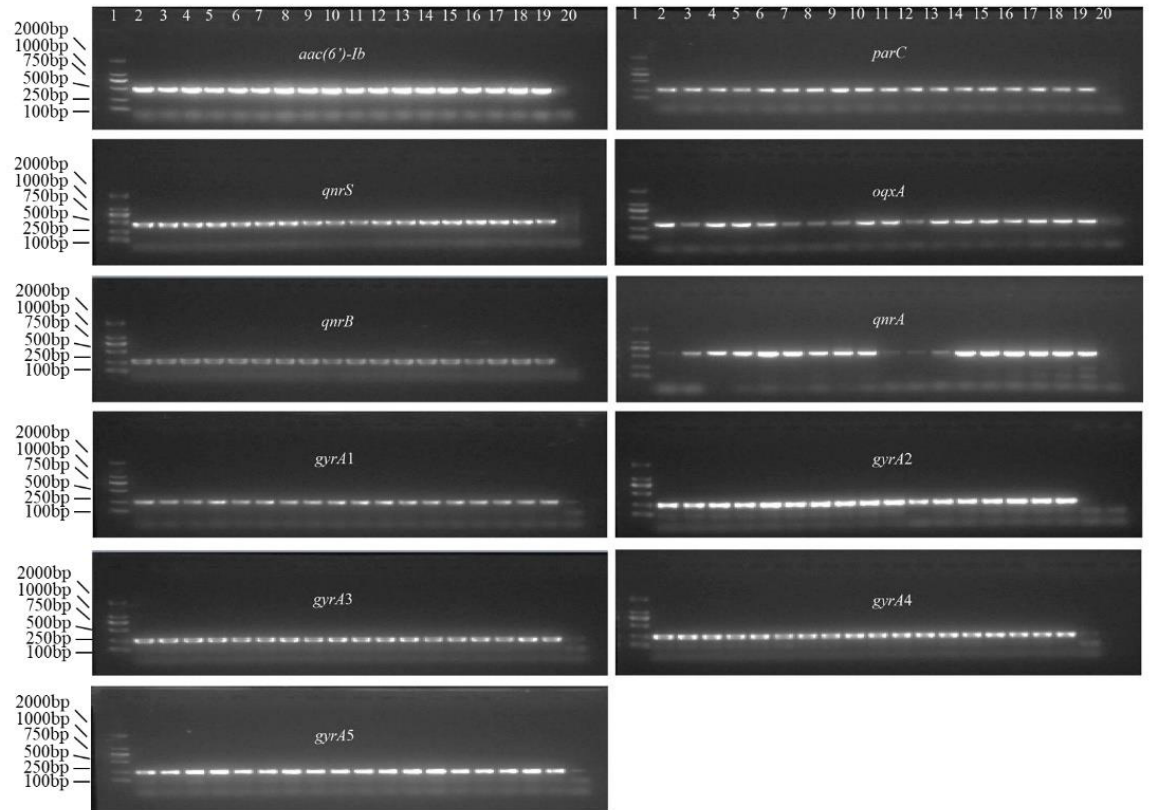
Figure 2. Genetic stability of the target DNA in recombinant strains of in E. coli DH5 α . In all gels, lane 1, DL 2000 DNA marker; lanes 2–4, amplicons of the target DNA in the original recombinant strains; lanes 5–7, 8–10, 11–13, 14–16, and 17–19, amplicons of the target DNA in the third, sixth, ninth, twelfth, and fifteenth generations of recombinant strains, respectively; and lane 20, double-distilled H 2 O, which served as the blank